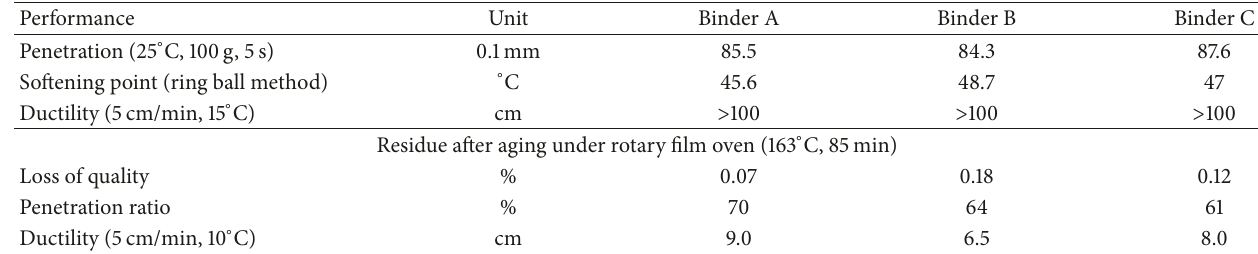
Table 1: Properties of neat